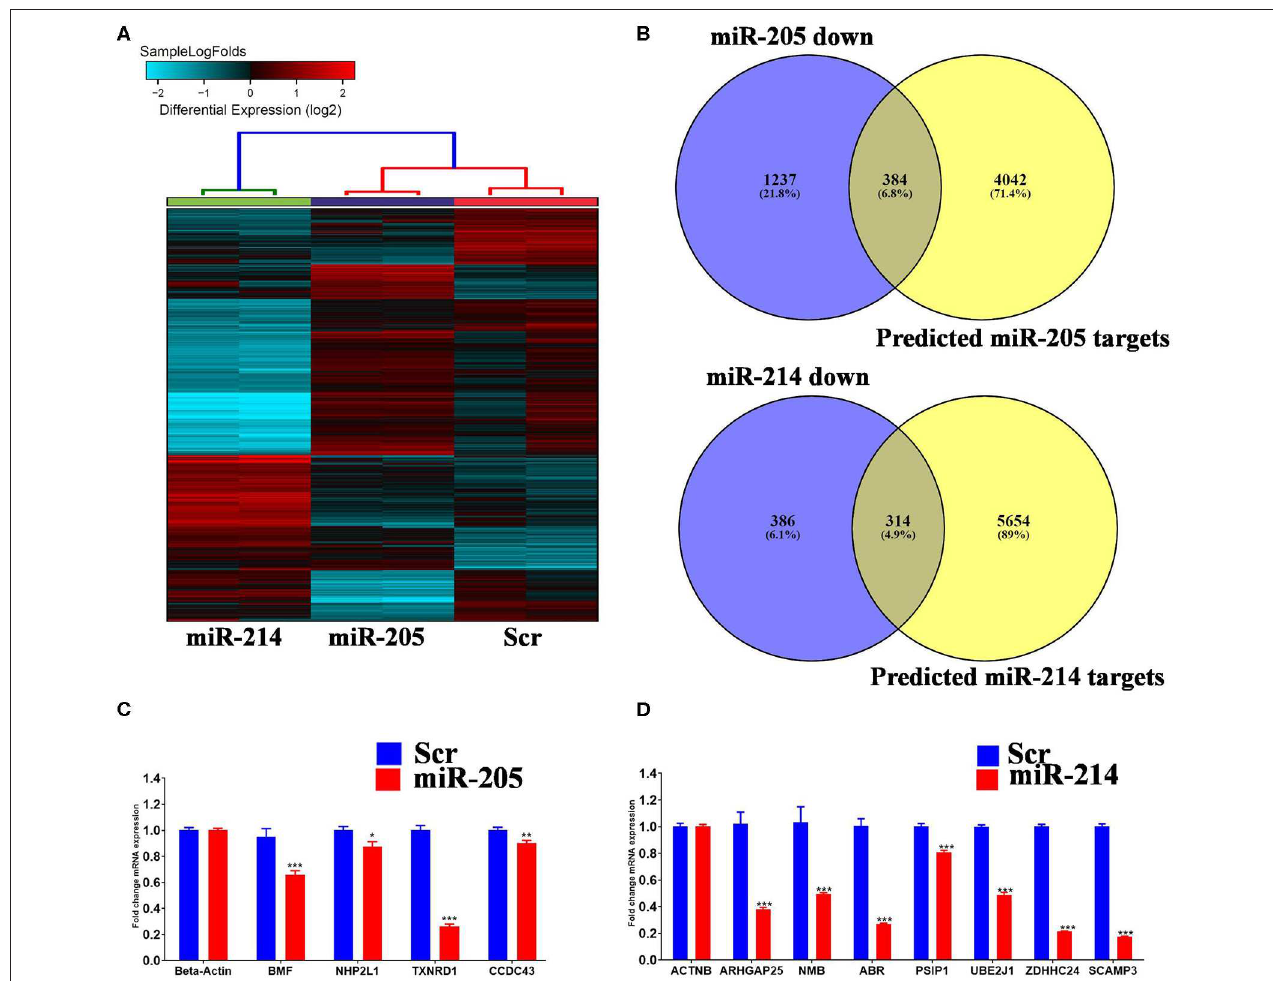
FIGURE 4 | Identification of miR-205-5p and miR-214-3p bona fide gene targets in BC cells. (A) Hierarchical clustering on differentially expressed transcripts in MDA-MB-231 cells transfected with hsa-miR-205, hsa-miR-214 compared to scramble control. Each column represents one replica and each row represents a transcript. Expression level of each gene in a single sample is depicted according to the color scale. (C,D) Venn diagram depicting the overlap between the predicted gene targets for hsa-miR-205-5p or hsa-miR-214-3p (based on TargetScan algorithm) and the downregulated genes in MDA-MB-231 cells overexpressing the respective miRNA. (B) The expression levels of selected genes targets for hsa-miR-205-5p or hsa-miR-214-3p were validated using qRT-PCR in MDA-MB-231 cells overexpressing the respective miRNA. Data are presented as mean ± S.E., n = 6. The two-tailed t -test was used to compare different treatment groups. * p < 0.05; ** p < 0.01; *** p <